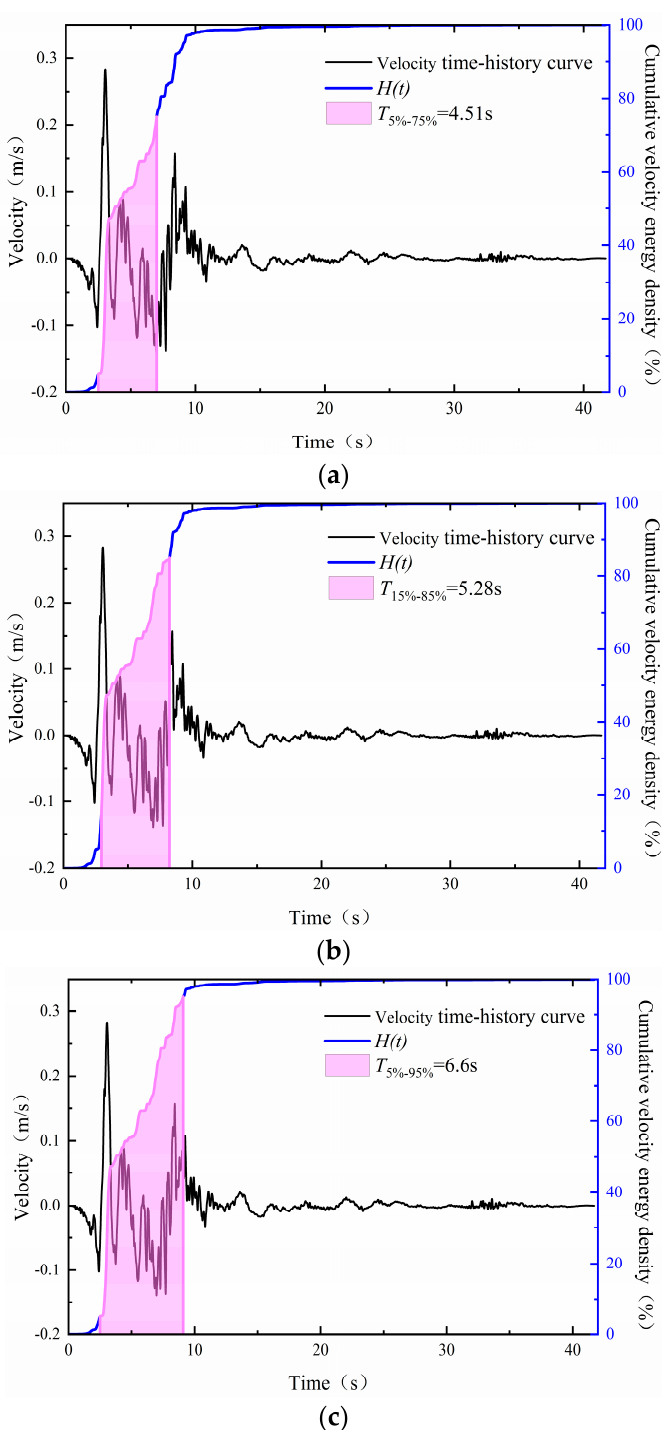
Figure 1. Plots of the duration of an NF earthquake record with velocity impulse for illustration of EVD. ( a ) 5–75% ( b ) 15–85% ( c ) 5–95%.